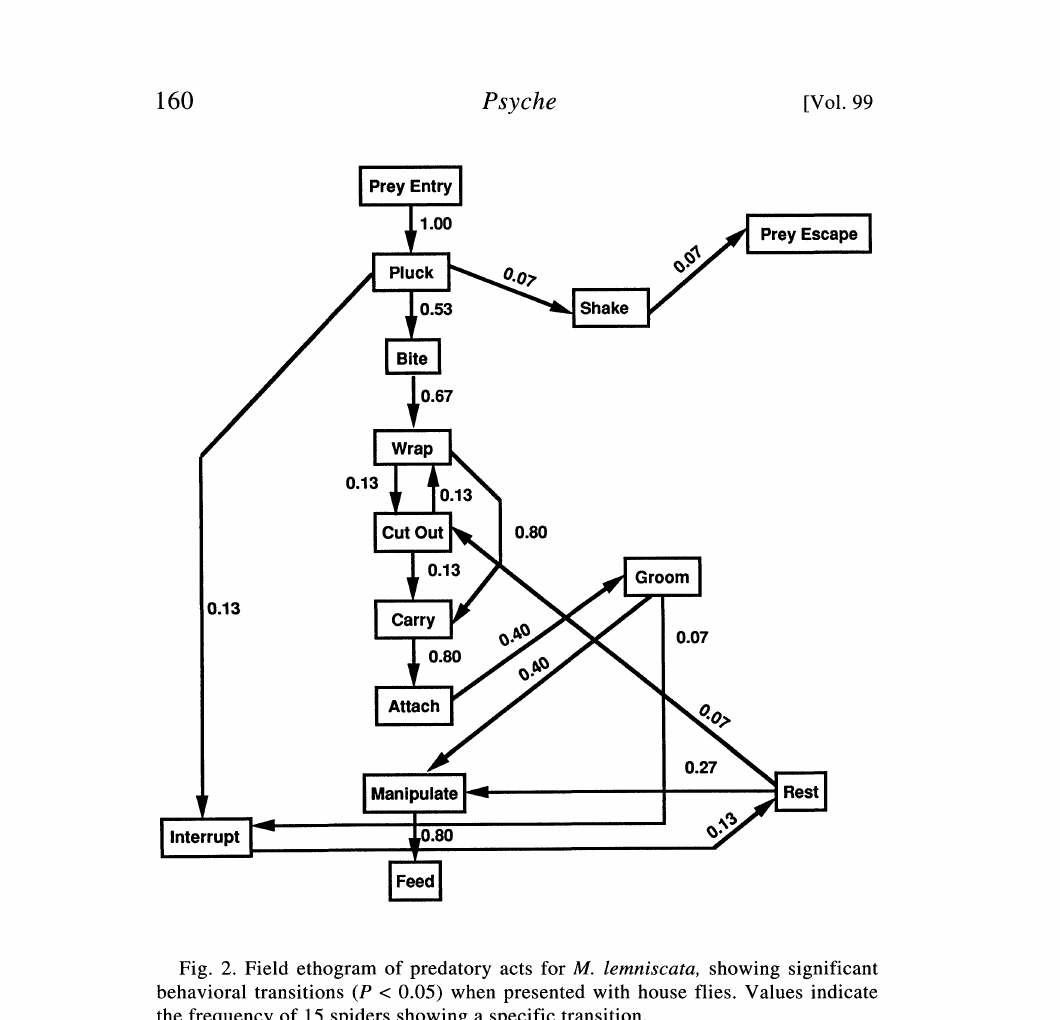
Fig. 2. Field ethogram of predatory acts for M. lemniscata, showing significant behavioral transitions (P < 0.05) when presented with house flies. Values indicate the frequency of 15 spiders showing a specific